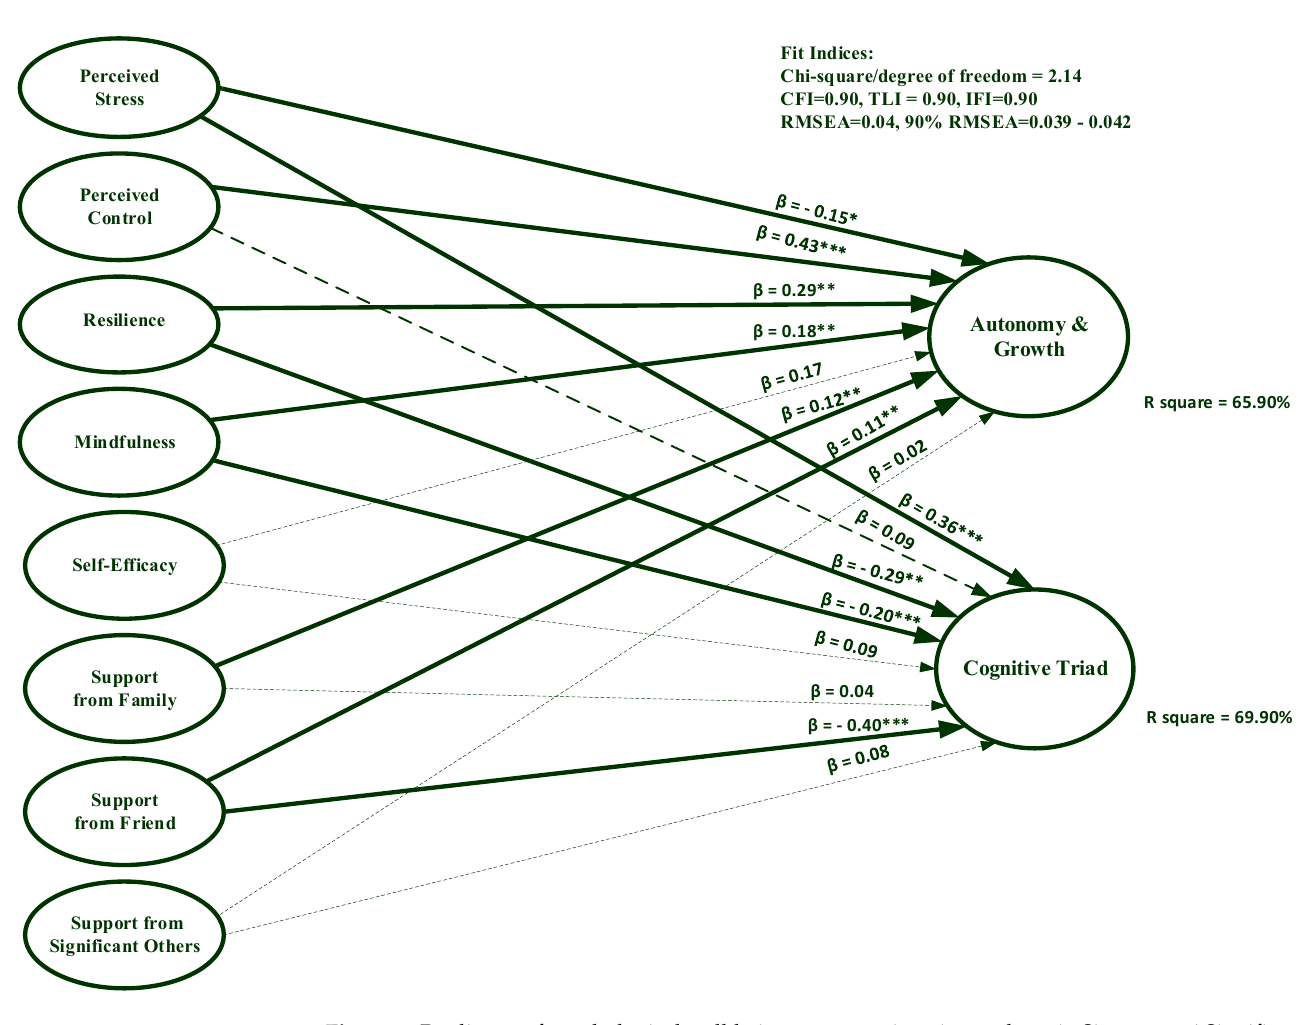
Figure 2. Predictors of psychological well-being among university students in Singapore. * Significant at 0.05, ** significant at 0.01, *** significant at 0.001